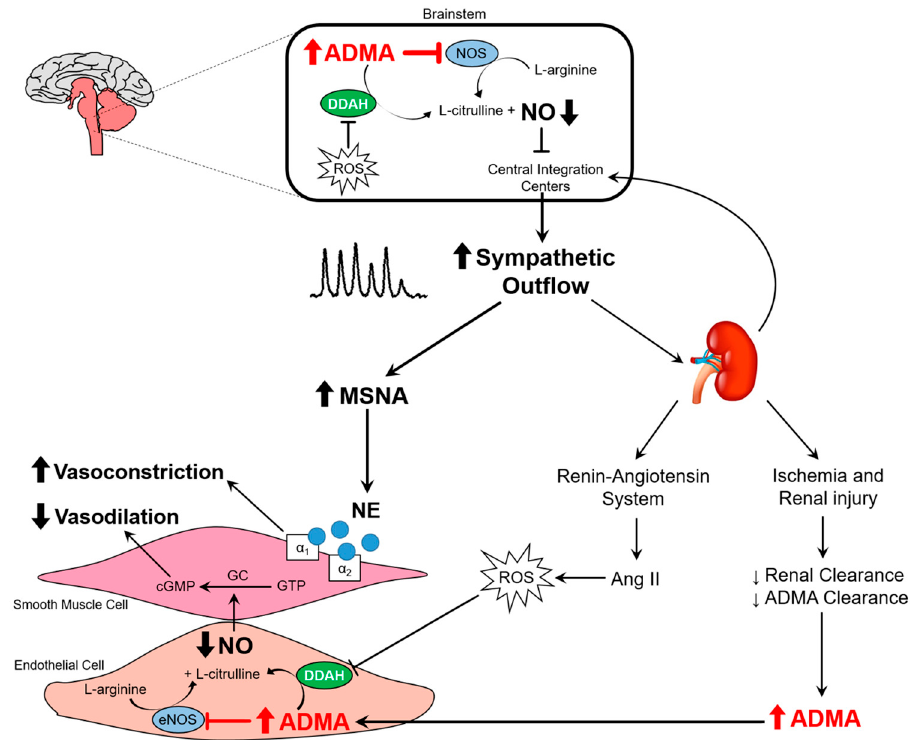
Figure 5. Schematic illustration depicting the effects of elevated ADMA in the brainstem and the peripheral circulation. Reduced dimethylarginine dimethylaminohydrolase (DDAH) activity and renal clearance of ADMA leads to elevated plasma ADMA concentrations in chronic kidney disesase (CKD). Elevated ADMA in the brainstem inhibits NOS and reduces central nitric oxide (NO) production, contributing to higher central sympathetic outflow. This greater SNA results in peripheral vasoconstriction. When prolonged, the sympathetic overactivity leads to a host of other deleterious consequences as outlined in the text of the review. In the periphery, elevated ADMA inhibits NOS and decreases NO, thereby reducing endothelium-mediated vasodilation. Greater sympathetically-mediated vasoconstriction and lower endothelium-mediated vasodilation contributes to increased vascular tone and higher blood pressure. ROS, reactive oxygen species; eNOS, endothelial nitric oxide synthase; NE, norepinephrine. ⱶ - denotes inhibition. (See text for further details).